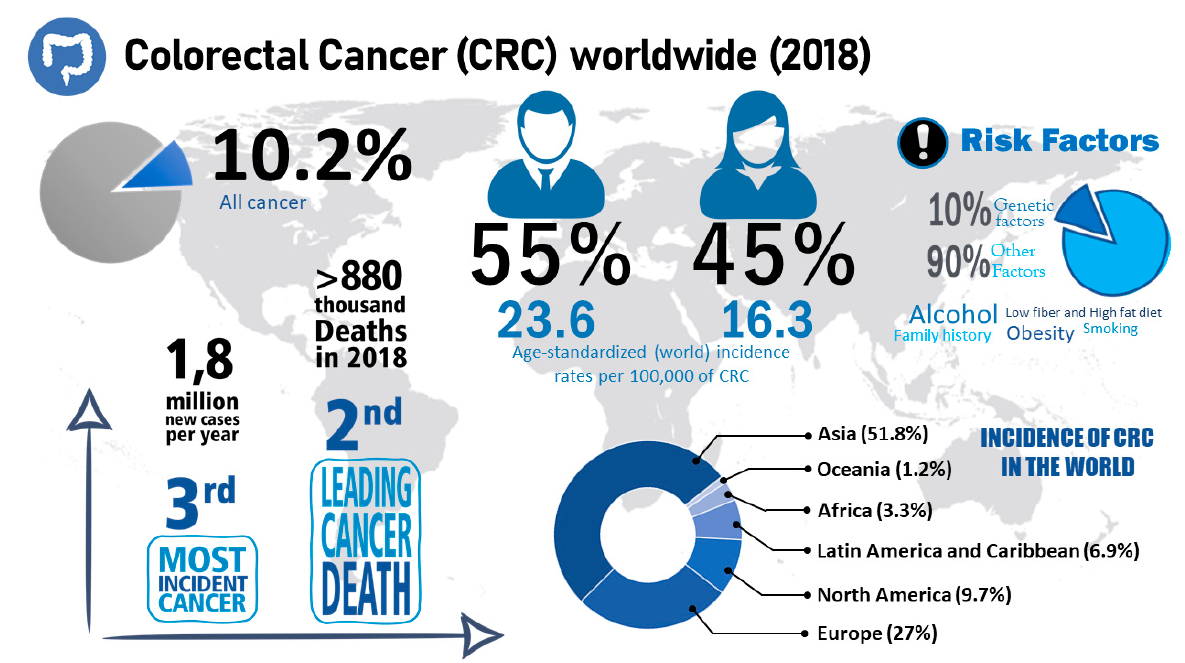
Figure 2. Characteristics of CRC. This figure presents data from CRC statistics [28], such as incidence, number of deaths and risk factors related to CRC.